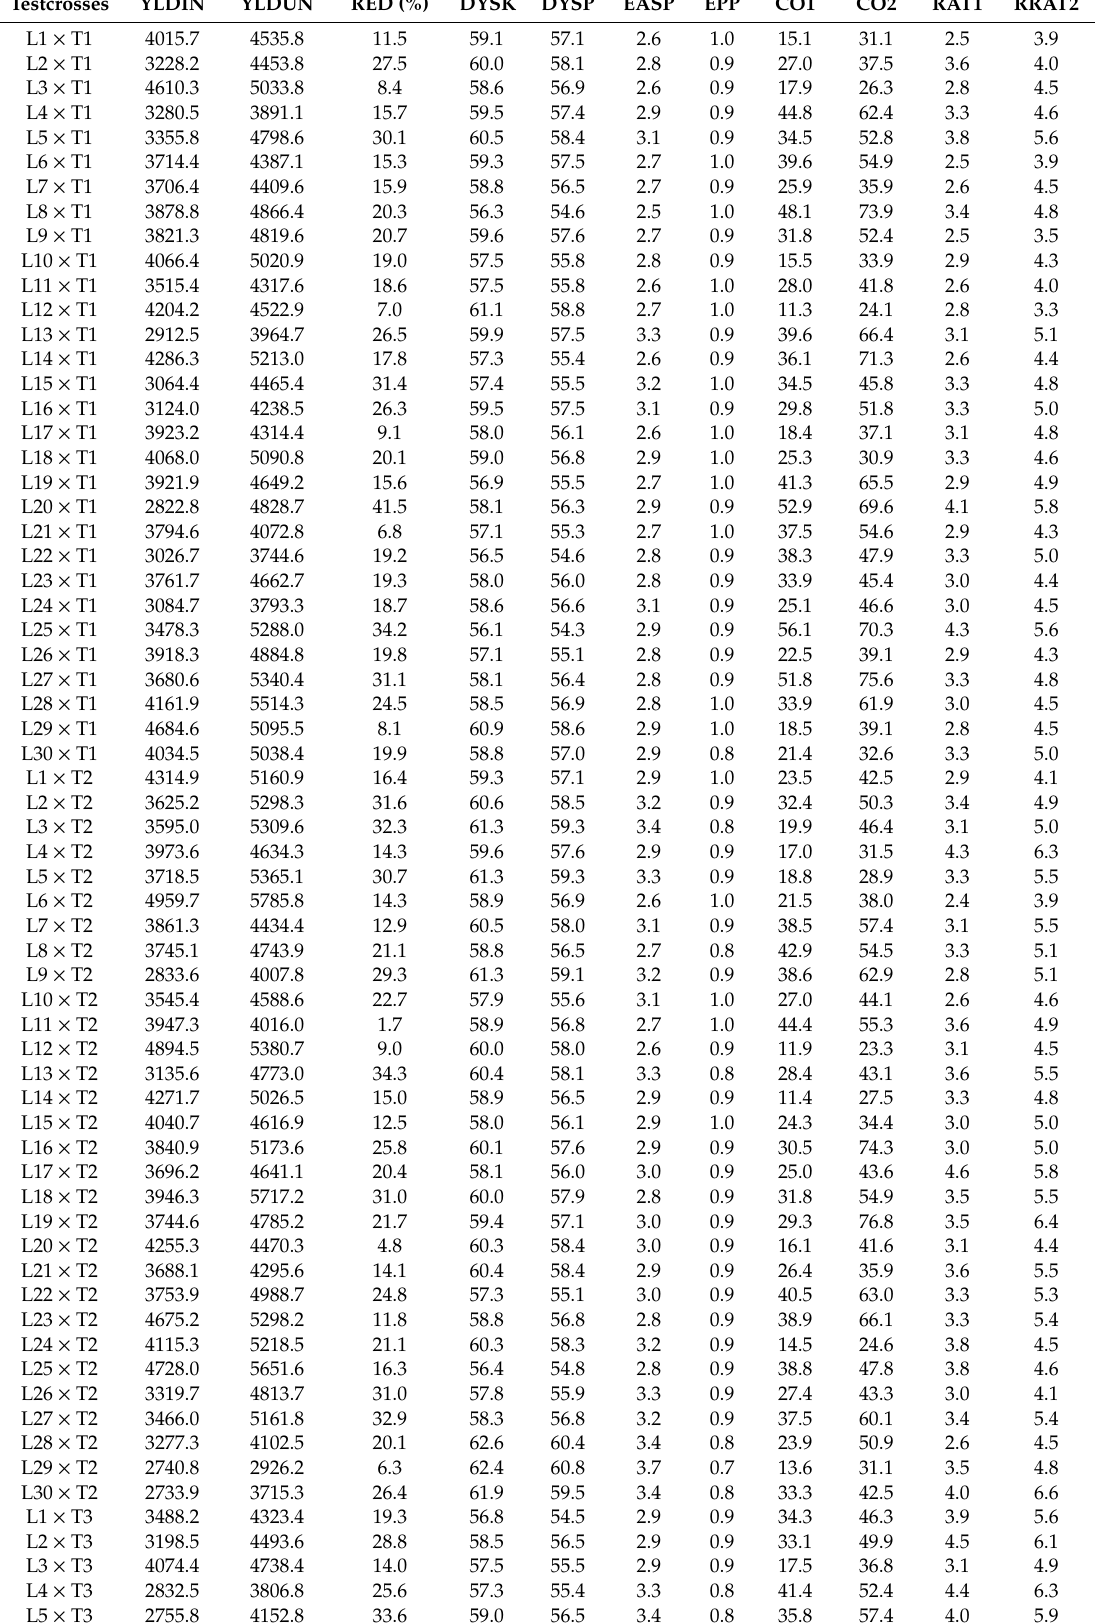
Table A3. Agronomic performance of testcrosses for some selected traits under artificial Striga infestation. Testcrosses YLDIN L1 ×